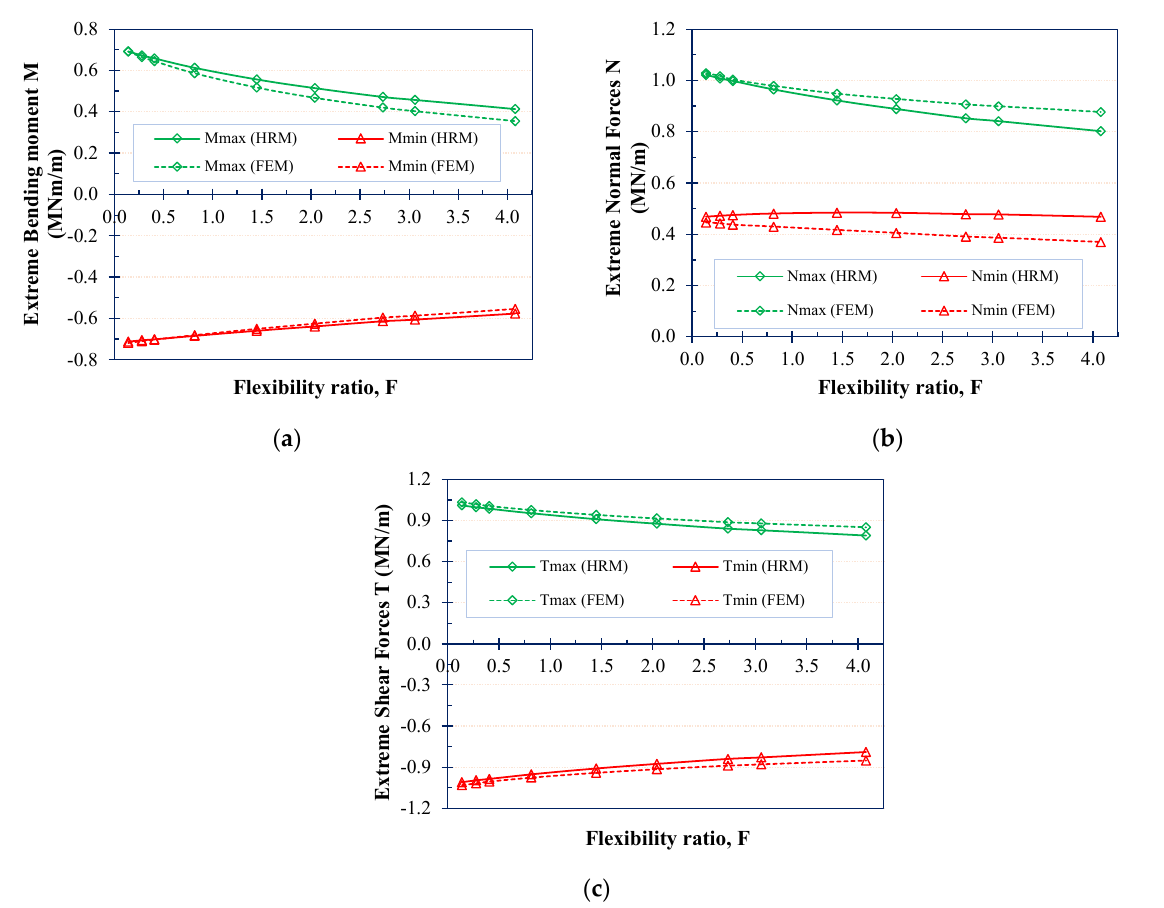
Figure 7. Effect of flexibility ratios F on internal forces in the square tunnel: ( a ) Extreme bending moments M; ( b ) Extreme normal forces N; ( c ) Extreme shear forces T. Table 3. Analysis of the effect of the flexibility ratio of tunnel lining F on the internal forces.